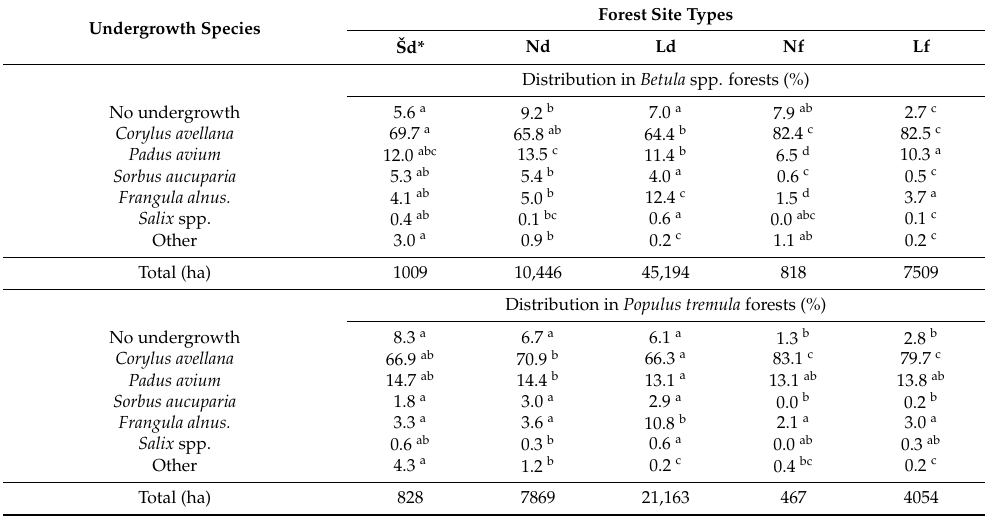
Table 4. Percentage distribution of the predominant undergrowth species area in Betula sp., Populus tremula , and Alnus incana stands growing in different forest site types. The values followed by different letters a, b, and c indicate statistically significant differences between different forest site types within each undergrowth species at p <